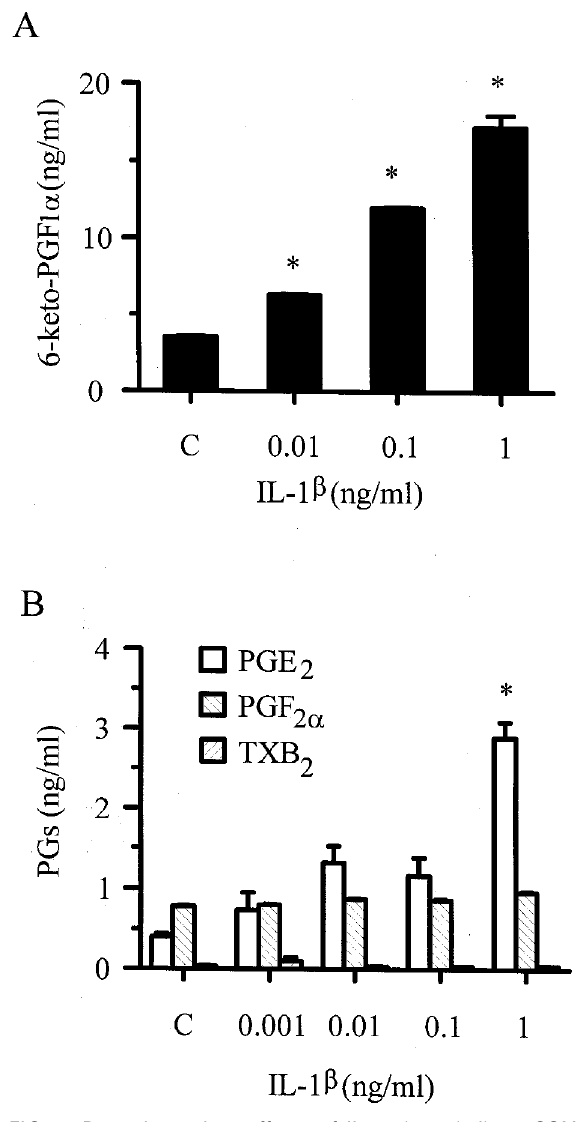
FIG. 1. Dose-dependent effects of IL-1 b (1 ng/ml) on COX activity in HUVEC. COX activity was measured by the formation of 6-keto-PGF 1 (panel A), PGE 2 (panel B), PGF 2 a a (panel B) and TXB 2 (panel B) in the presence of exogenous arachidonic acid (10 m M; 10min). Data are expressed as mean±SEM of 12 determinations from at least four separate experimental days. * P < 0.05 when compared to untreated HUVEC at 24h